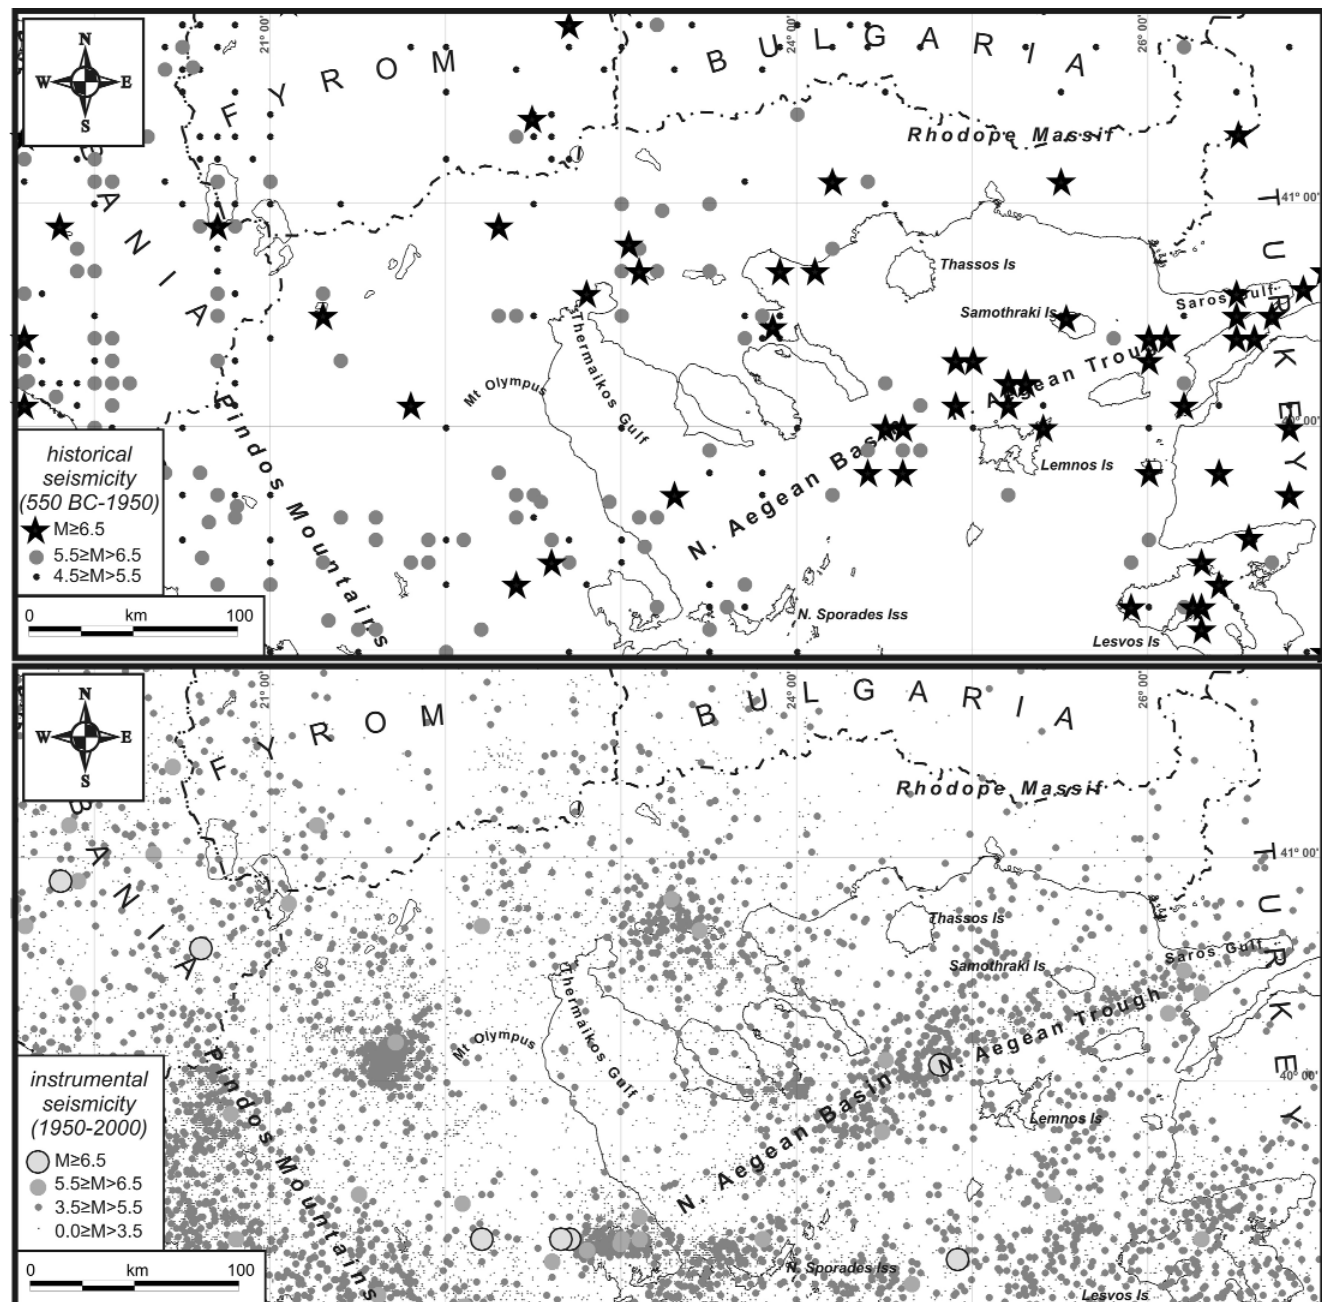
Figure 2. Historical seismicity (top; from Papazachos and Papazacou 1997) and instrumental seismicity (bottom; from the National Observatory of Athens, Greece) in the Northern Aegean